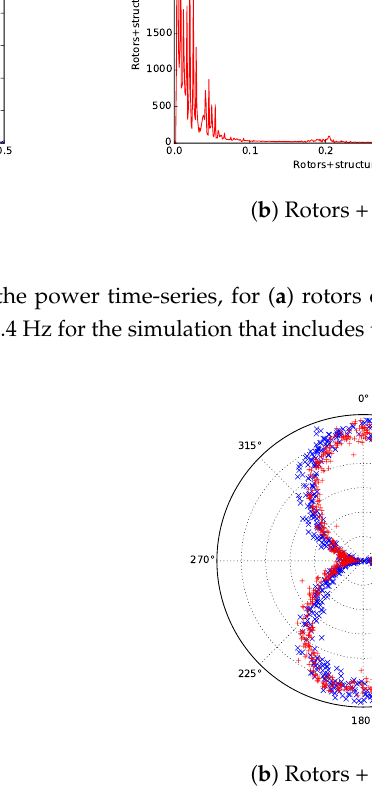
Figure 19. Polar plots of blade position versus power fluctuations above 0.3 Hz, for rotors T1 and T2, in ( a ) the rotors-only simulation and ( b ) including the structure. 0 ◦ means the blade is pointing upwards, and power fluctuations are plotted from − 7.5–7.5 kW. T1 rotates anti-clockwise and T2 rotates clockwise. The extent of the power fluctuations is approximately ± 7.5 kW in ( b ), whereas in ( a ) it is a third of the size, at ± 2.5